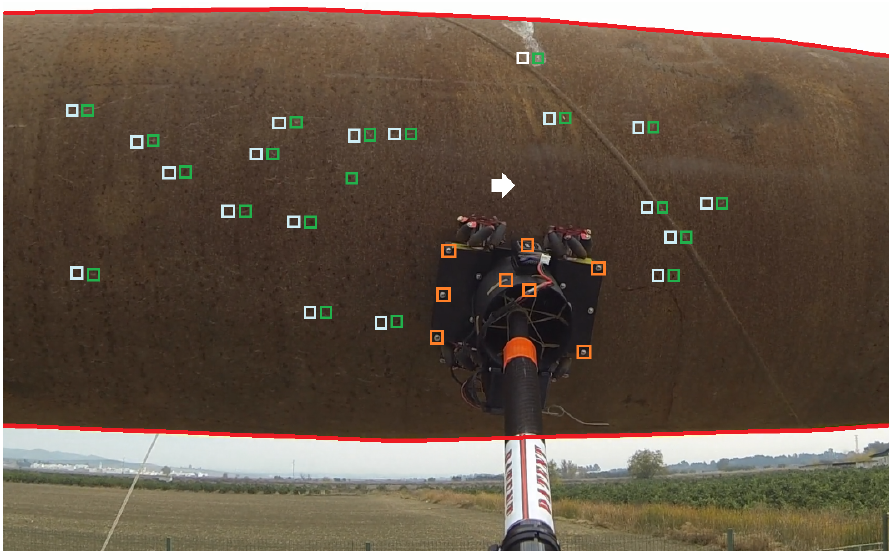
Figure 8. Picture of the on-board camera used for the visual-based relative localization system. The green rectangles are used to mark the SURF features in FS t that were correctly matched—after executing RANSAC—with features in FS t − 1 ,—marked with white rectangles. The matchings (of the end-effector) filtered out by RANSAC are marked with red rectangles. A small white arrow illustrates the relative displacement between the end-effector and the pipe between t − 1 and t